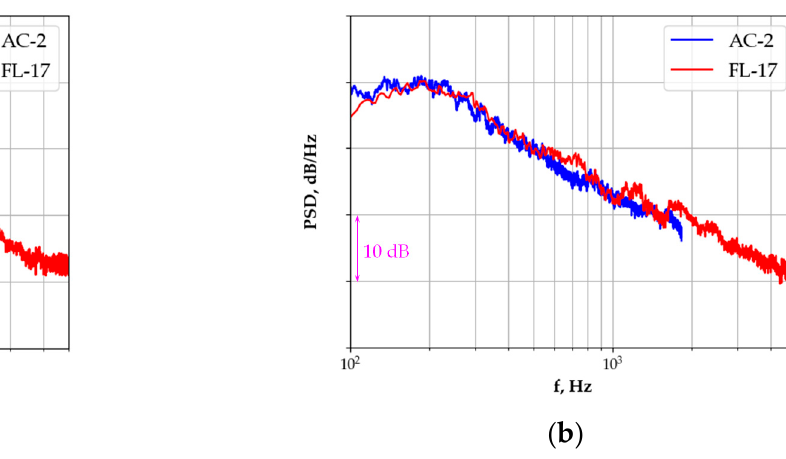
Figure 14. Comparison of the normalized spectra of the four-wheel landing gear model with the high main leg. Flow speed is 75 m s − 1 . Microphone is at ( a ) ( θ , φ ) = (70°, 20°), ( b ) ( θ , φ ) = (110°, 20°).